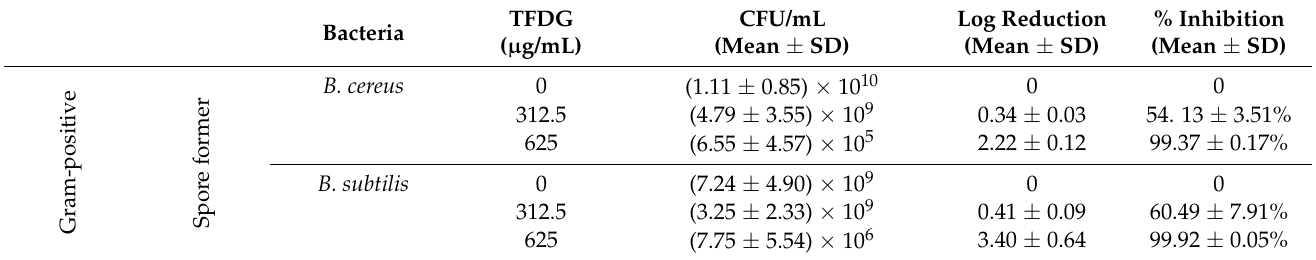
Table 3. Germination inhibition assay of both B. cereus and B. subtilis.